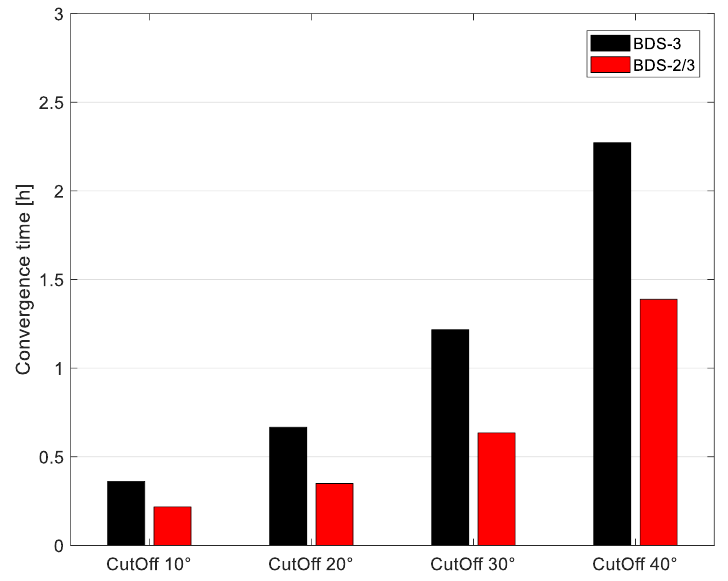
Figure 6. The mean of convergence time histograms.